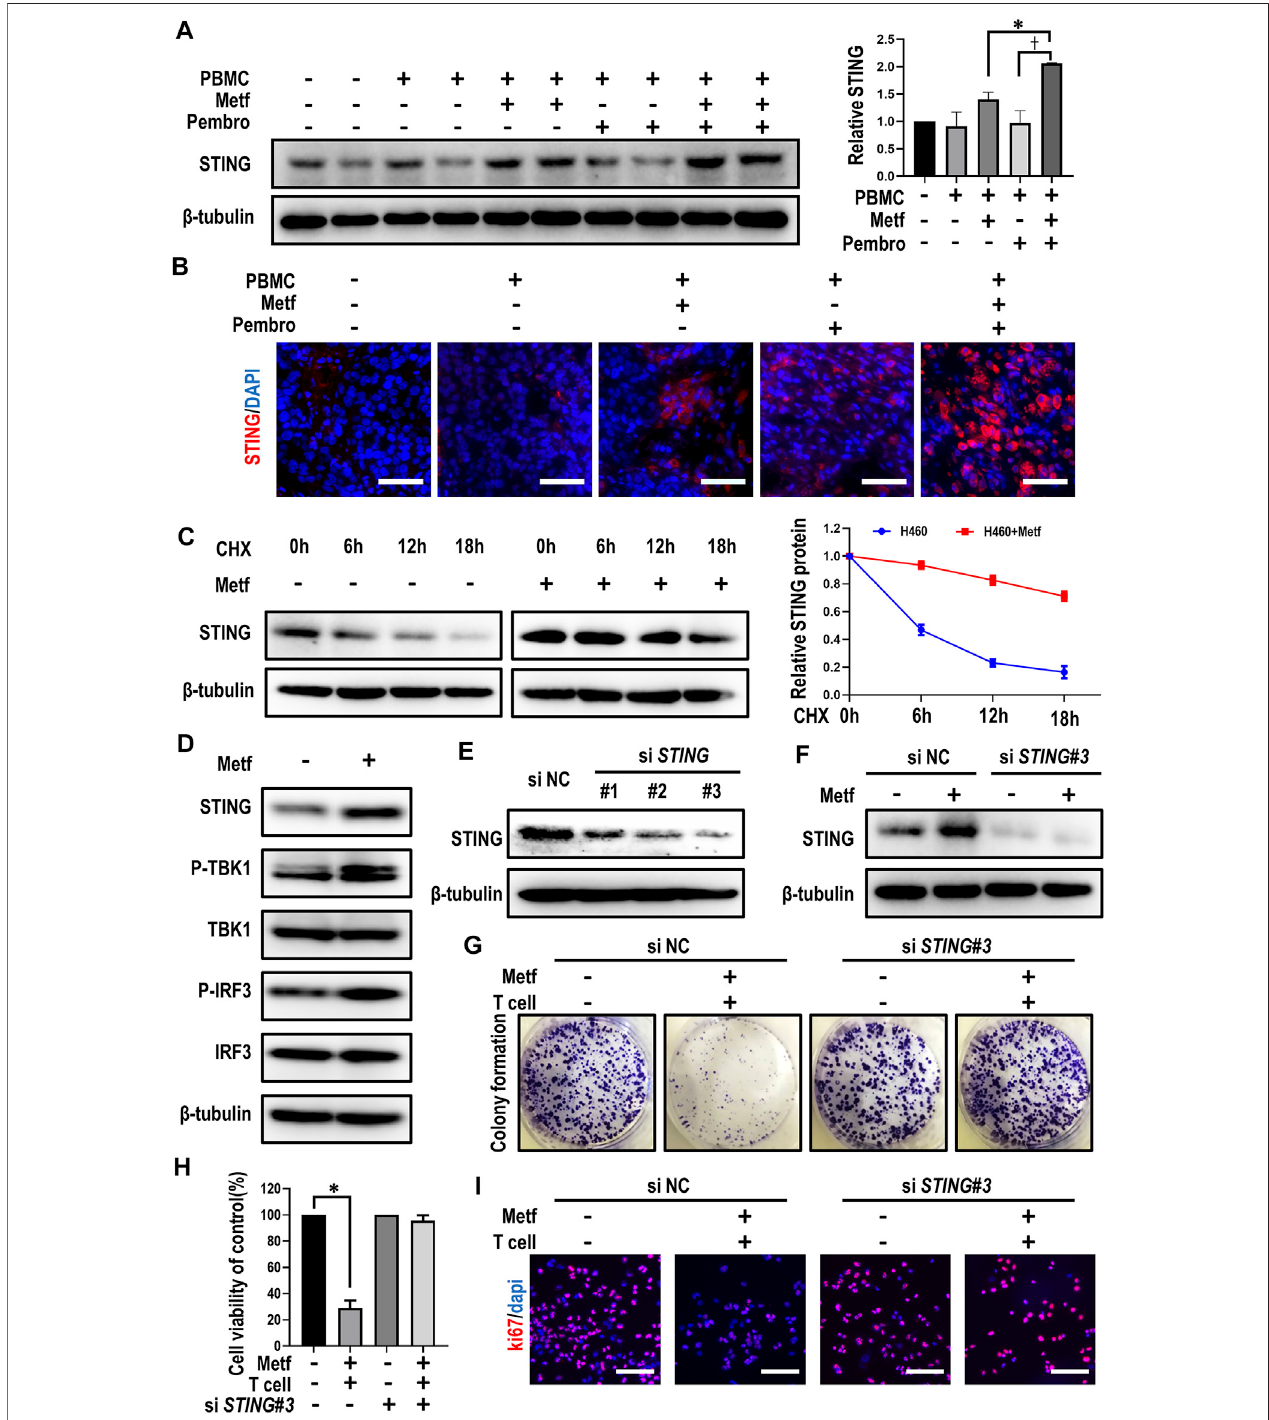
FIGURE3 | Metformin enhanced T cell-mediated killingthroughstabilization ofSTING. (A) ,Westernblot analysis ofSTING from tumor sections of each group and expression levels were presented. * p < 0.05; † p < 0.01. (B) , Immuno fl uorescence staining of STING from tumor sections of different groups as indicated. Scale bars: 30 μ m. (C) , H460 cells were treated with 10 μ M CHX at indicated intervals in the presence of metformin or not, and the level of STING was quanti fi ed using ImageJ software. (D) ,WesternblotanalysisofindicatedproteinsinH460cellswithmetformintreatment. (E) ,Westernblotshowingtheexpression levelsofSTINGinH460 cells after transfection with control or STING siRNAs, respectively. (F) , Western blot analysis of STING expression under metformin treatment after siRNA-mediated knockdown of STING. (G) , H460 cells transfected with control or STING siRNAs were co-cultured with activated T cells (cancer cells to T cells ratio, 1:1) for 48 h with or without metformin and then subjected to crystal violet staining. (H) , Cell viability CCK-8 assay for cells treated as indicated. Data are shown as mean ± SEM of triplicate determinations. * p < 0.01. (I) , Ki67 incorporation assay on H460 cells treated as indicated. Cells were counterstained with DAPI.